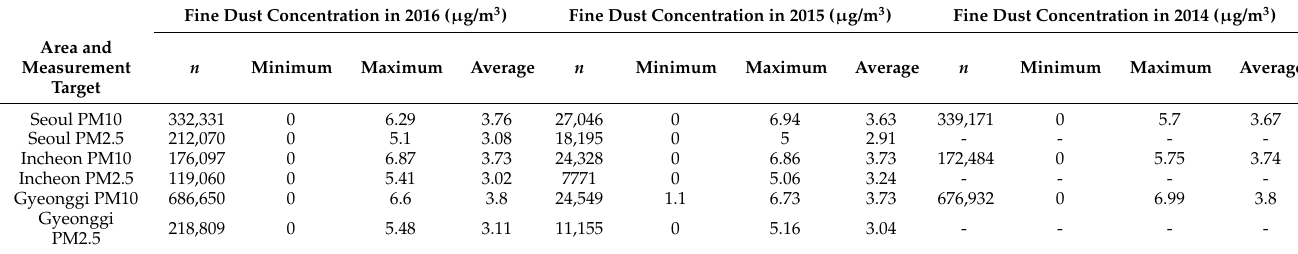
Table 3. Concentration (log-linear) of fine dust (PM10 and PM2.5) in Seoul, Incheon, and Gyeonggi. Fine Dust Concentration in 2016 ( µ g/m 3 )